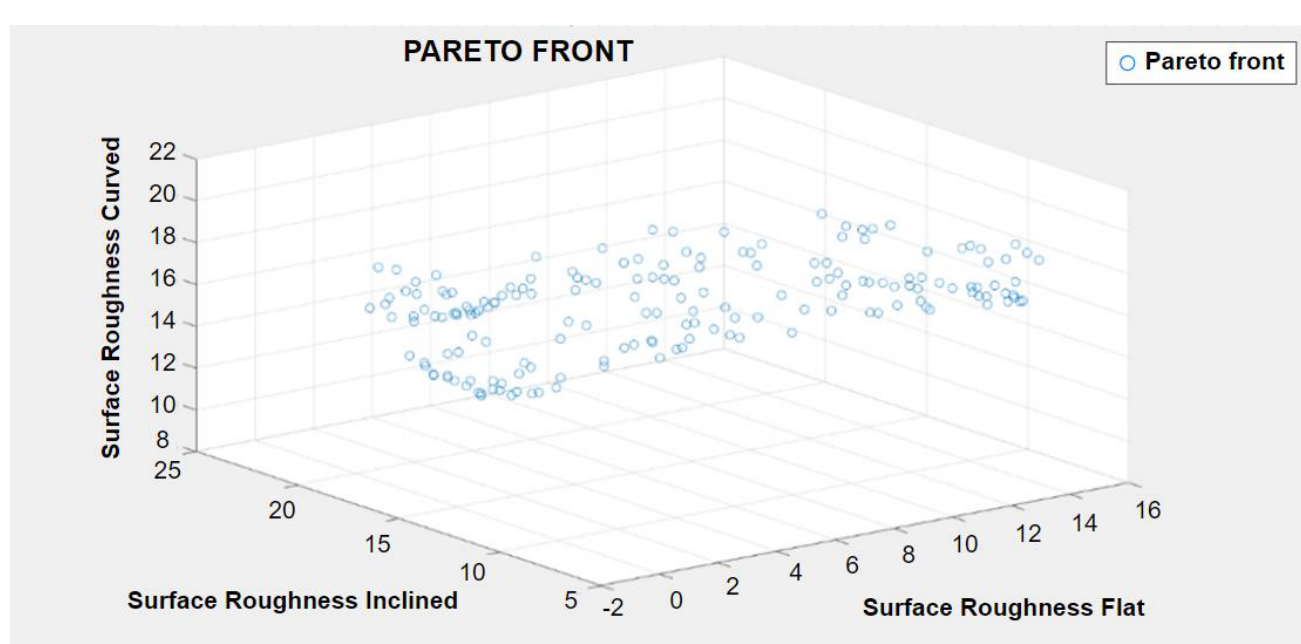
Figure 9. The generated pareto front for minimizing the surface roughness.